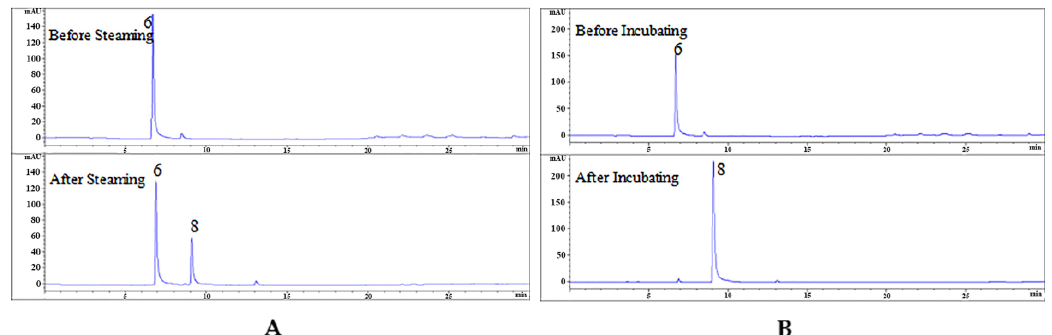
Figure 8. The HPLC chromatograms of GAS before and after enzymatic hydrolyzed steaming sample ( A ); incubating sample ( B ).